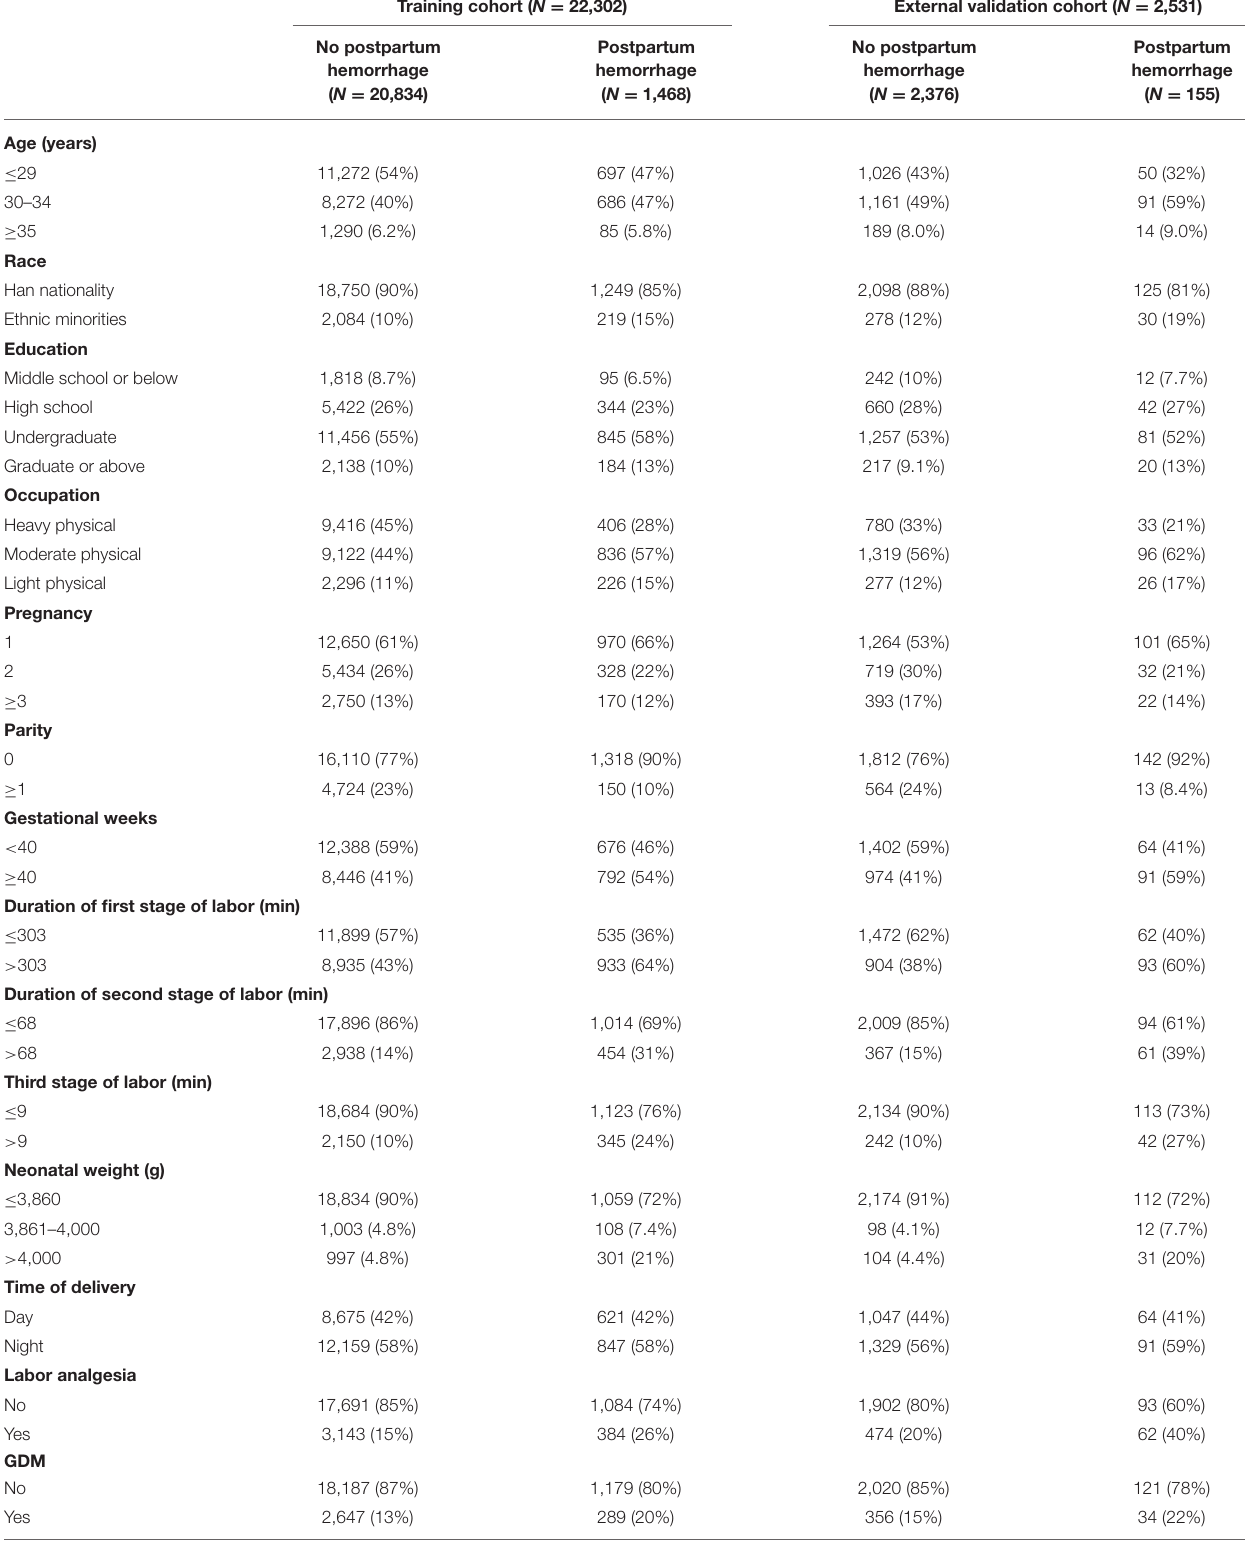
TABLE 1 | Patient